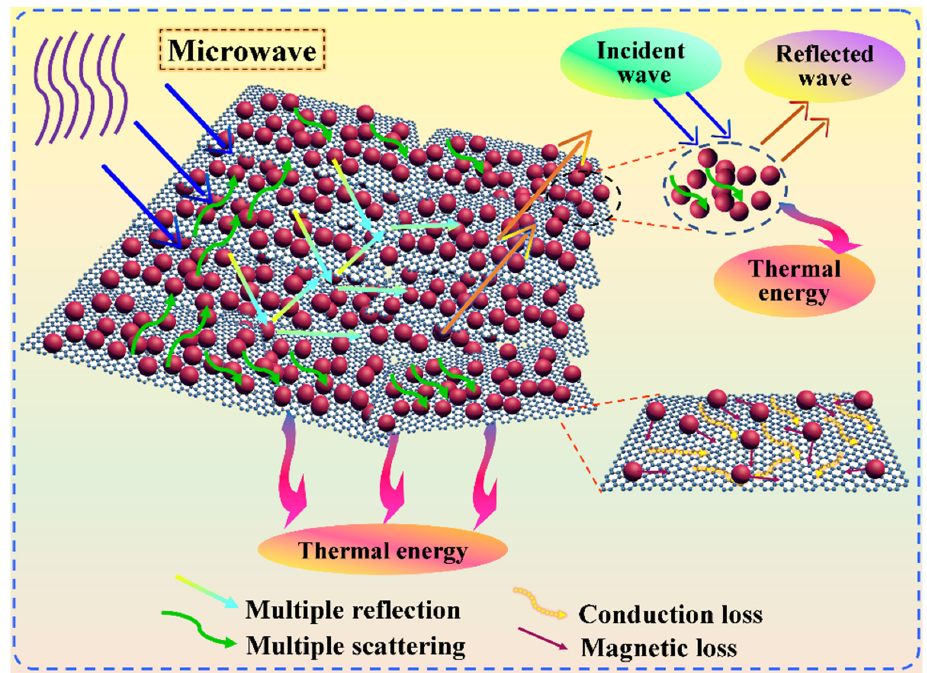
Figure 18. Scheme of microwave absorption mechanism for the PI/graphene/Fe 3 O 4 hybrid aerogel films.